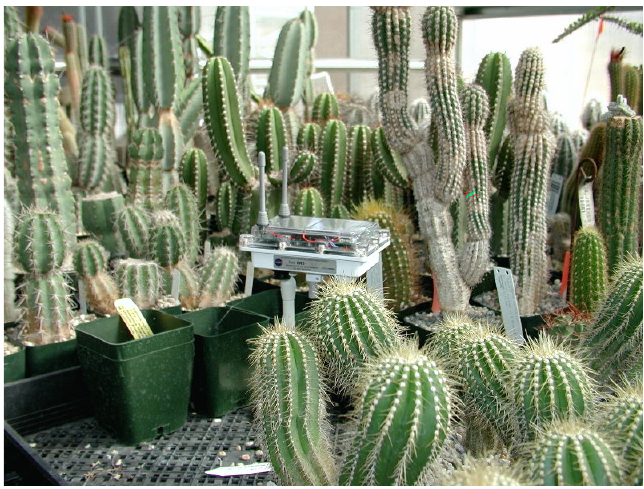
Figure 12. Sensor Web 3 pod deployed in the desert greenhouse at the Huntington Botanical Gardens.